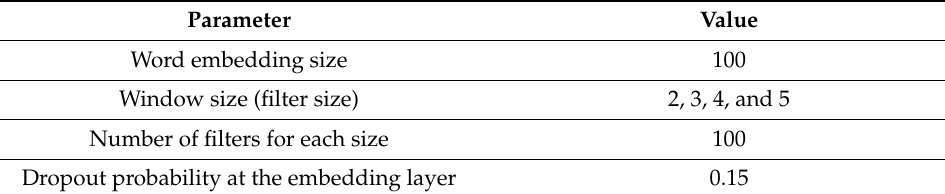
Table 4. Word embedding parameters.